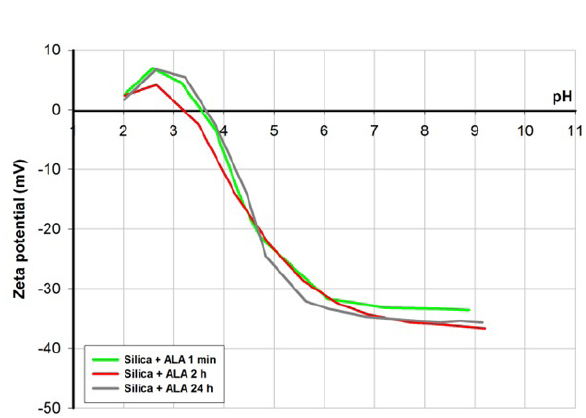
Figure 6: Zeta potential vs. pH of the silica with immobilized Amano Lipase A